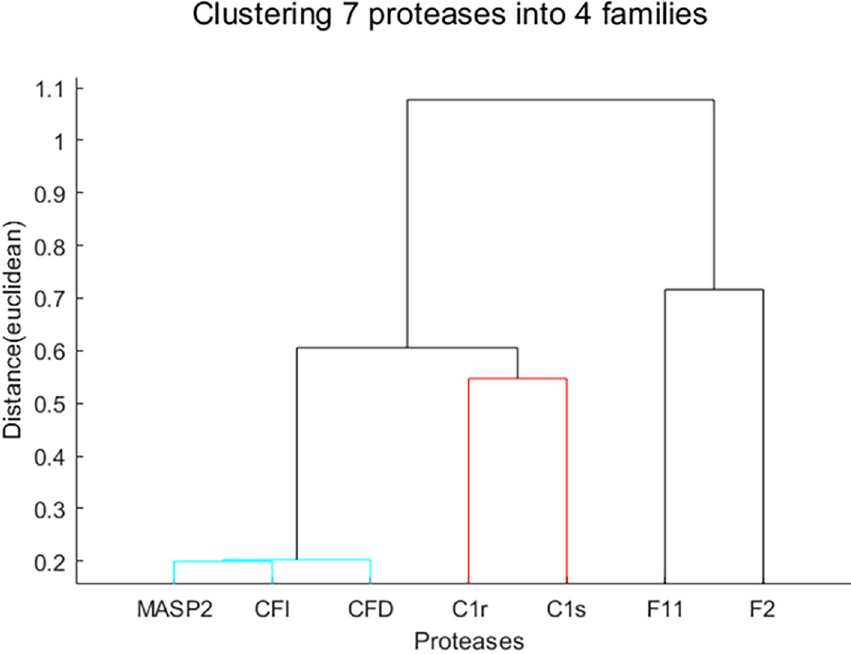
Fig 5. Hierarchical clustering of individual proteases led to 4 families. MASP2+CFI+CFD formed the most strongly correlated family, C1r + C1s formed the moderately correlated family, and F11 and F2 each served as its own family.